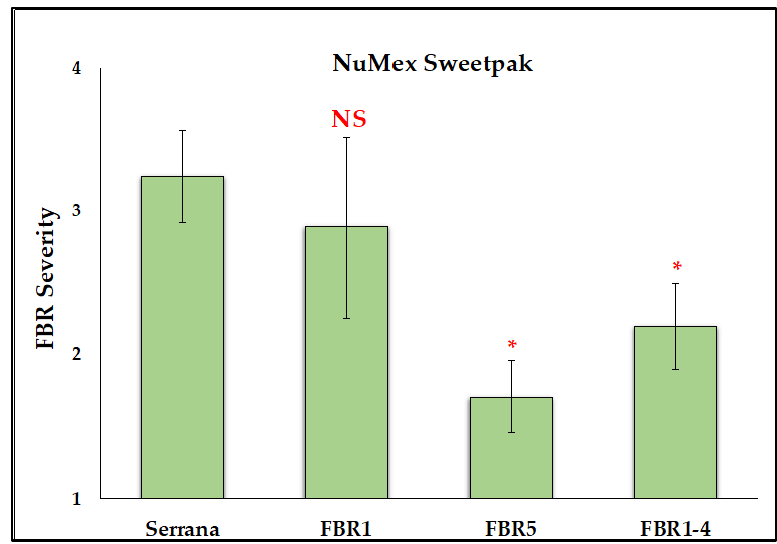
Figure 5. Increased levels of FBR resistance in the most advanced selections of ‘NuMex Sweetpak’ in comparison to the partially resistant check ‘Serrana’ in the year 2021. Error bars are the standard errors of the mean FBR severity. * refers to different from ‘Serrana’ and NS means not different from ‘Serrana’ at p < 0.05.